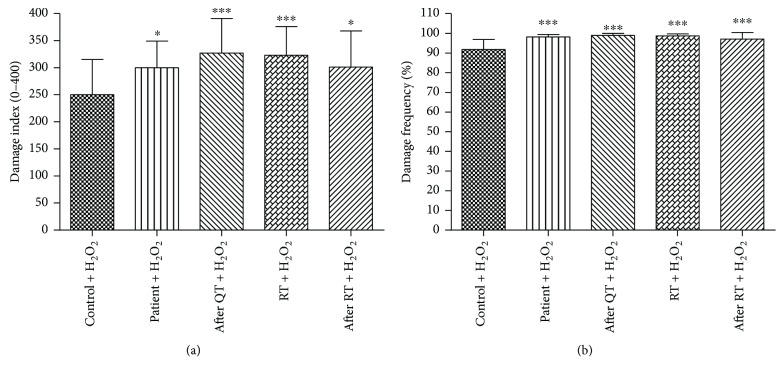
Damage index (a) and damage frequency (b) induced by H2O2 (challenge assay) to peripheral blood lymphocytes from breast cancer patients at diagnosis, during and after treatments and healthy controls. ∗Significance at P < 0.05 and ∗∗∗P < 0.001 compared to negative control (Kruskal-Wallis test).